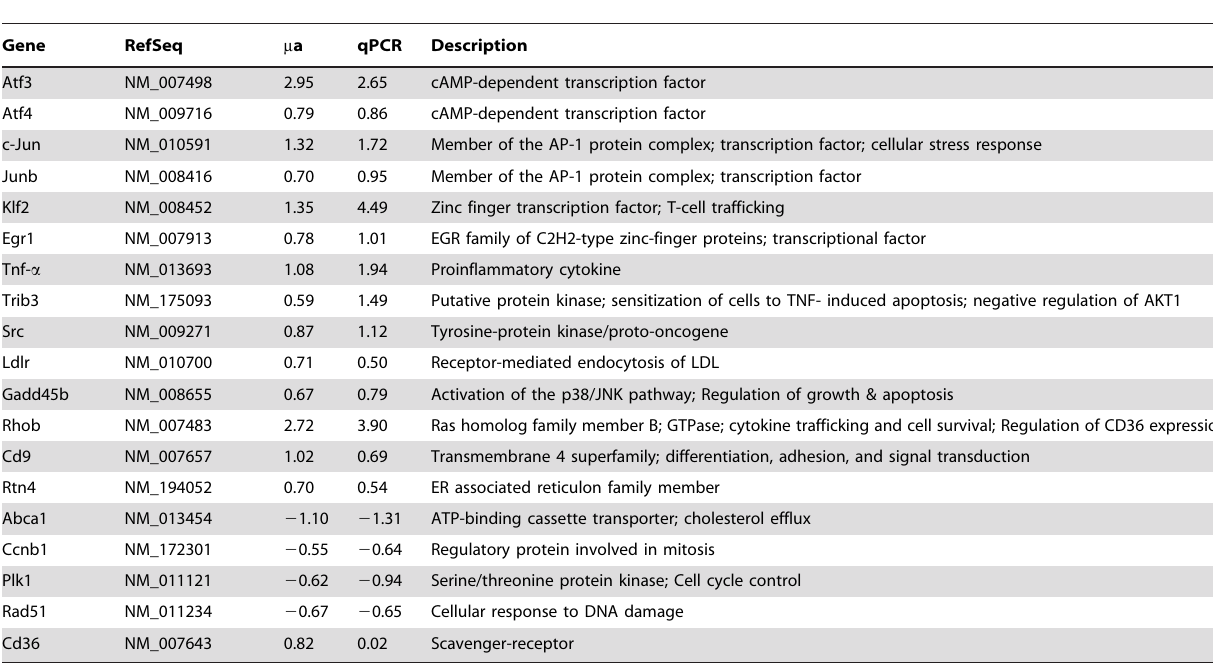
Table 2. Comparison of relative gene expression levels (log 2 fold changes) observed by microarray ( m a) and RT-qPCR (qPCR) analyses.